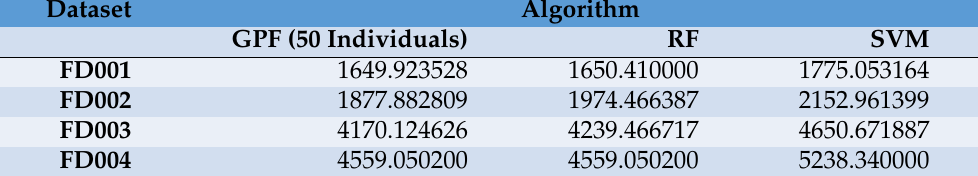
Table 12. The resulting MSEs of using the GPF versus purely using RF or